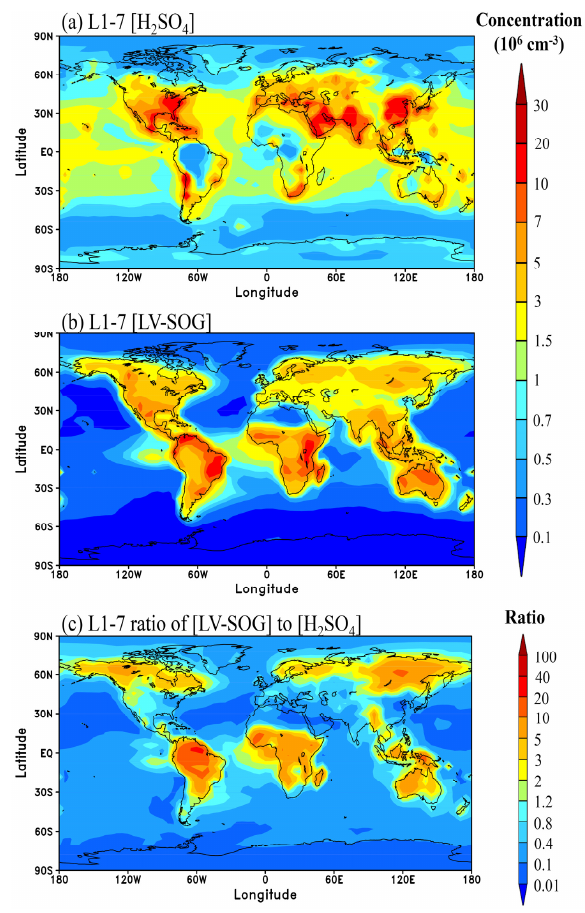
Figure 3. Fig. 3. Horizontal distributions (averaged over first seven model layers above Earth’s surface: 0–1km) of annual mean values of (a) H 2 SO 4 gas concentration ([H 2 SO 4 ]), (b) LV-SOG concentra- tion [LV-SOG], and (c) ratio of [LV-SOG] to [H 2 SO 4 ]. The simu- lation was carried out with GEOS-Chem+APM for year 2005 with a horizontal resolution of 4 ◦ × 5 ◦ and 47 vertical layers up to 0.01 hpa (GEOS-5 meteorological